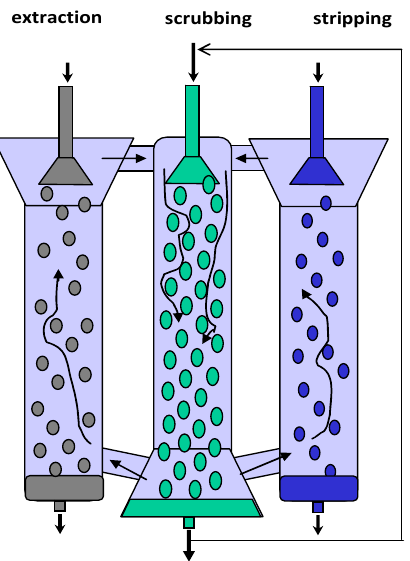
Figure 3. Schematic arrangement of the multi-phase extraction apparatus.